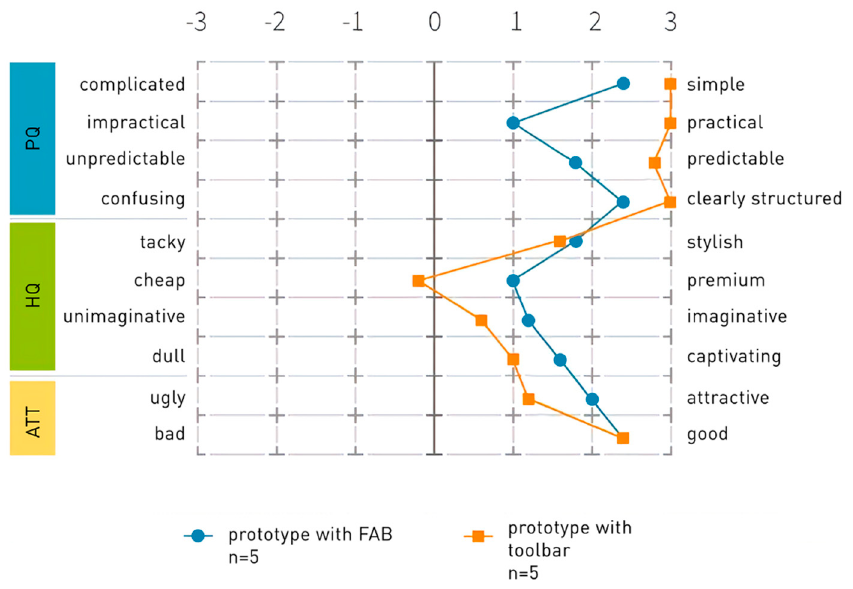
Figure 1. Diagram of perceived QoE qualities of interactive prototypes A and B.